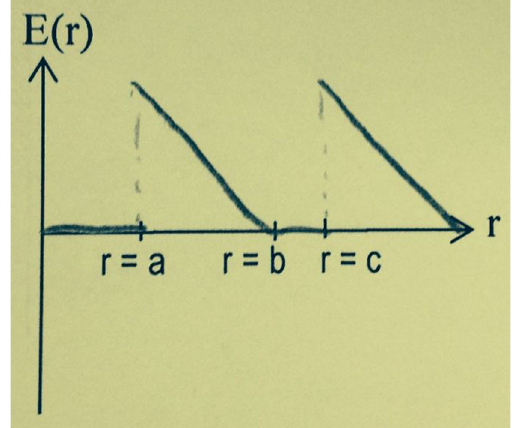
FIG. 7. Electric field plotted by Mike (an interviewed student).